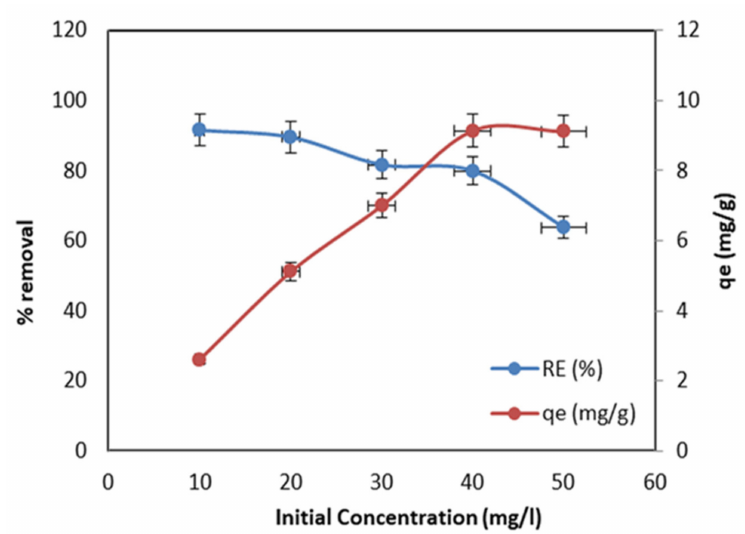
Figure 6. Effect of different MO concentrations on adsorption capacity and removal efficiency (pH 2.5; 0.07 g, adsorbent dose; and 24 h, contact time)